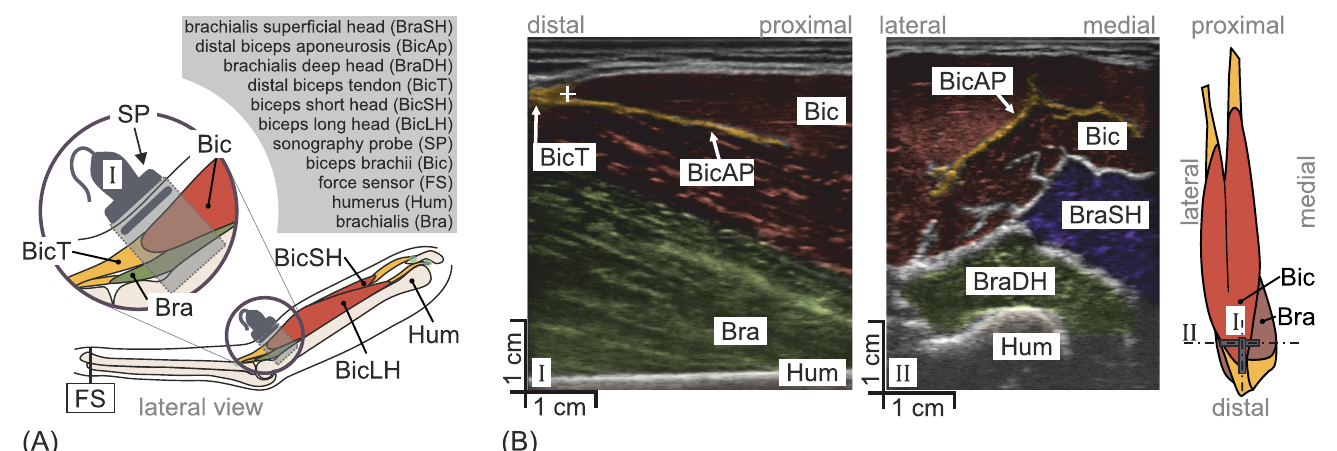
Fig 4. In (A) the lateral view of the experimental setup in form of an anatomical sketch is shown . An ultrasonic probe (SP) is used to image a cross-section of the distal part of the upper arm. The cross-section contains the distal tendon of the biceps brachii (BicT). Simultaneously, the force generated by the arm is measured with a force sensor (FS) near the wrist (cmp. Fig 3). The biceps brachii (Bic), its long head (BicLH), its short head (BicSH), brachialis (Bra) and humerus (Hum) are also labeled. In (B) the ultrasonic images of two orthogonal cross-sections are depicted. The orientation of both imaging planes are marked in a sketch on the right side, which shows the anterior perspective on the Bic and Bra. Orientation I was the only imaging plane used during the presented study (cmp. (A)). The structures of the Bic are marked in red. The junction of Bic and BicT was observable in this view (white cross) as well as part of the aponeurosis (BicAP). Imaging plane II is orthogonal to imaging plane I. The furcation (wing-like structure) of the aponeurosis was observable (marked in orange) as well as different parts of the Bra muscle group—the brachialis deep head (BraDH) in green and the brachialis superficial head (BraSH) in blue.